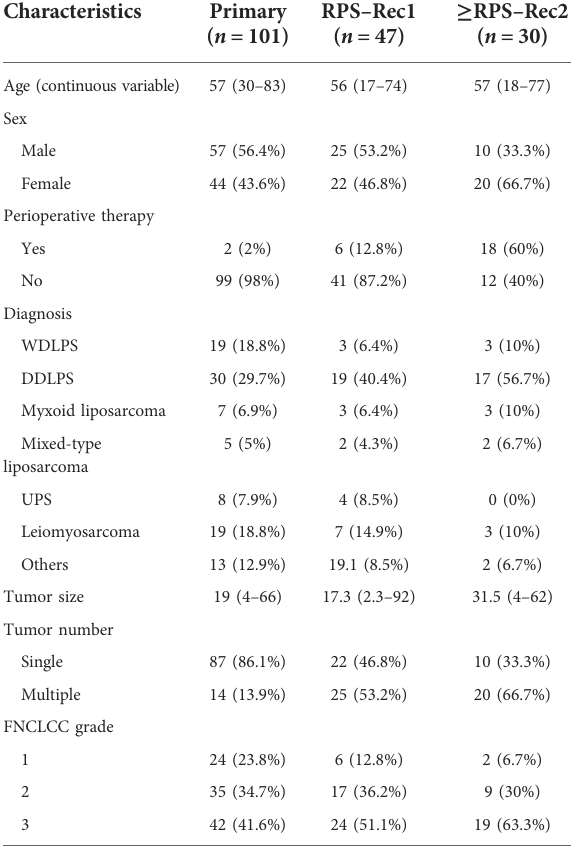
TABLE 1 Clinical characteristics of the